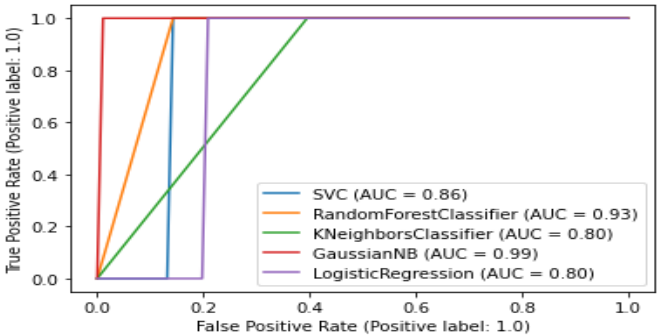
Figure 3: ROC curve for AUC score for each ML; Source: Adopted by